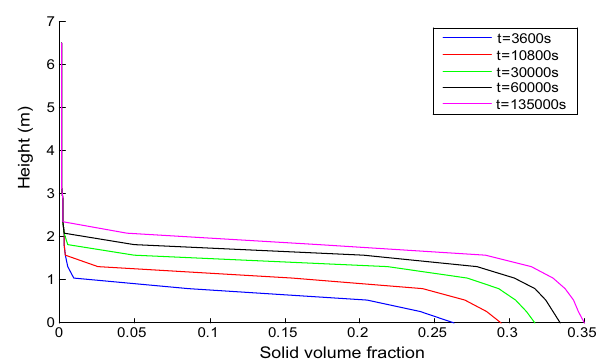
Fig. 6 Results of dynamic simulation for the d 80 = 275 l m, F = 40 g/t and constant amount of pH 9 ( Q F = 0.465 m 3 /s, u F- = 0.027, Q D = 0.0358 m